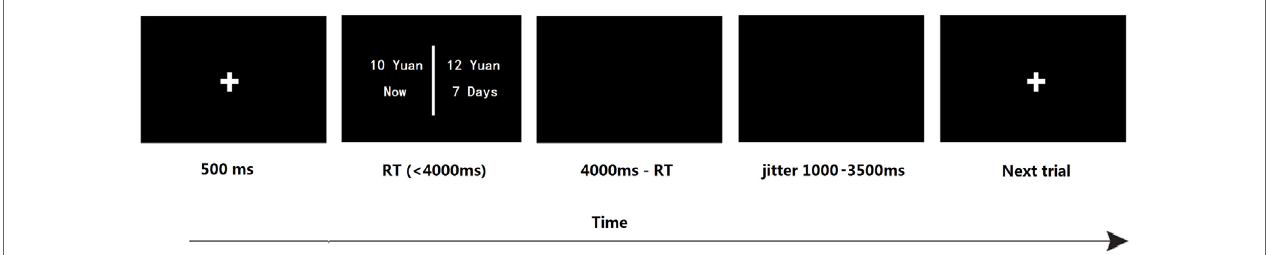
FigUre 1 | The timeline of one trial in the delay discounting task. The immediate but smaller option is fixed on 10 Yuan; in the delayed but larger options, monetary amounts ranged from 12 to 15, 20, 30, 40, and 50 Yuan, and the delay time ranged from 6 h to 1, 3, 7, 30, and 90 days. “Yuan” is the basic unit of money in China.